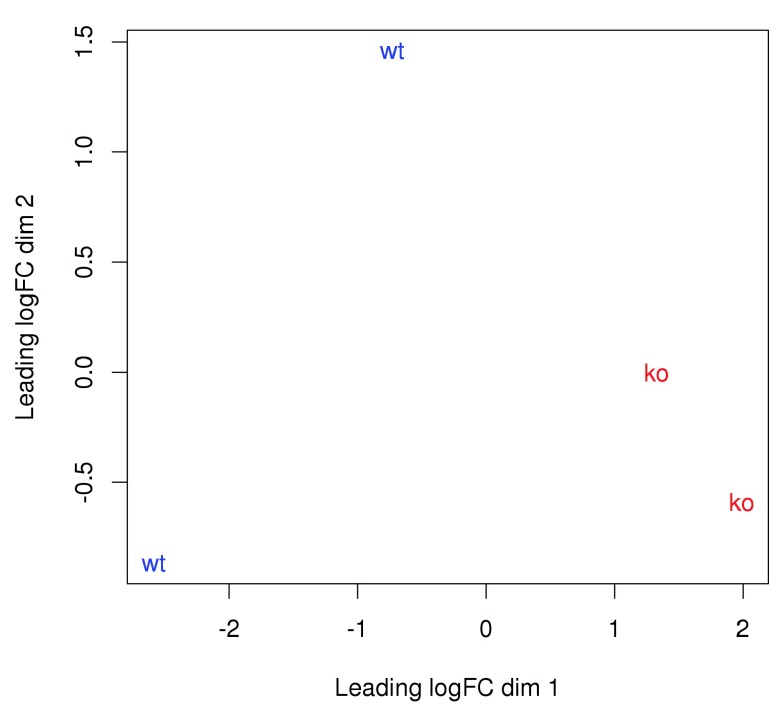
MDS plot with two dimensions for all libraries in the CBP data set.Libraries are labelled and coloured according to the genotype. A larger top set of windows was used to improve the visualization of the genome-wide differences between the WT libraries.